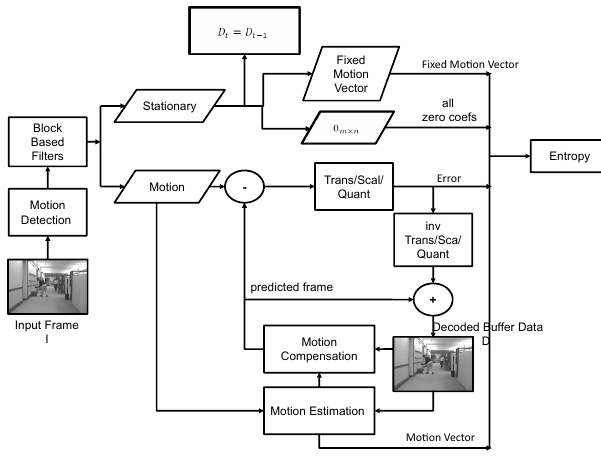
Figure 9. Proposed encoding architecture for Motion Estimation based video